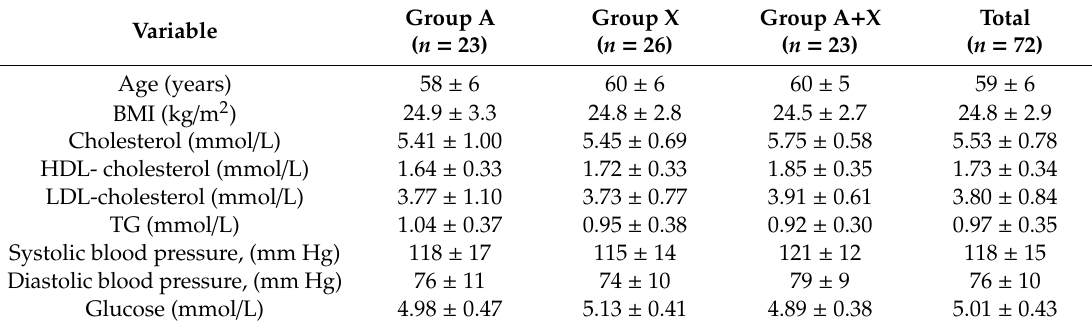
Table 1. General baseline characteristics of the subjects according to intervention group or total (mean ± SD).